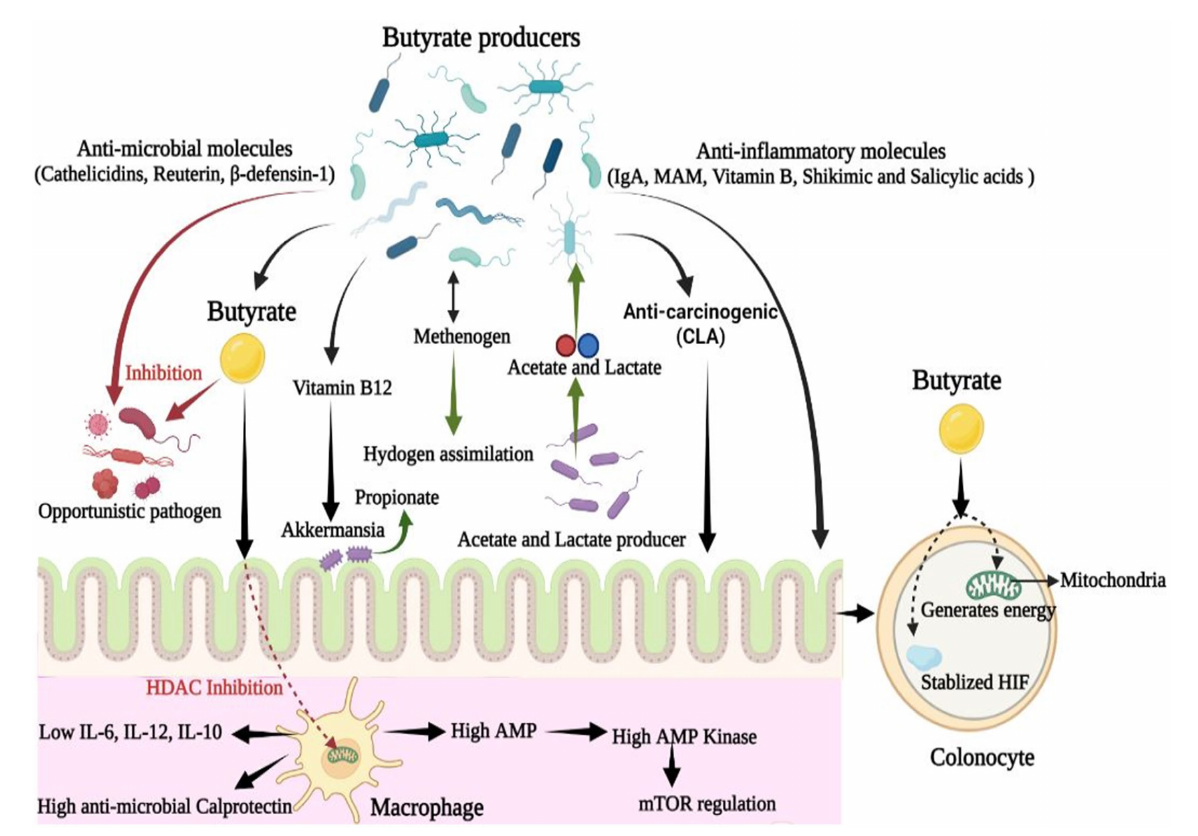
FIGURE 2 Dynamic role of butyrate producing microbial communities in gut: Along with butyrate, butyrate-producing communities also produce various bioactive molecules that are anti-microbial, anti-inflammatory, and anti-carcinogenic in nature. These molecules are of therapeutic importance in alleviating gut-associated disorders and maintaining gut-homeostasis (CLA, Conjugated Linoleic Acid; IL, Interleukin; MAM, Microbial Anti- inflammatory